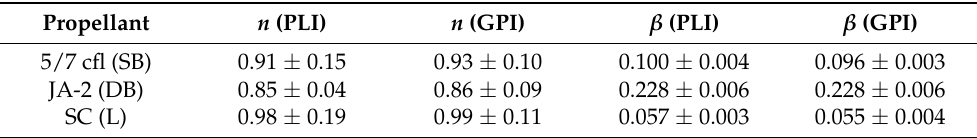
Table 3. The values of the exponent n and the coefficient β .